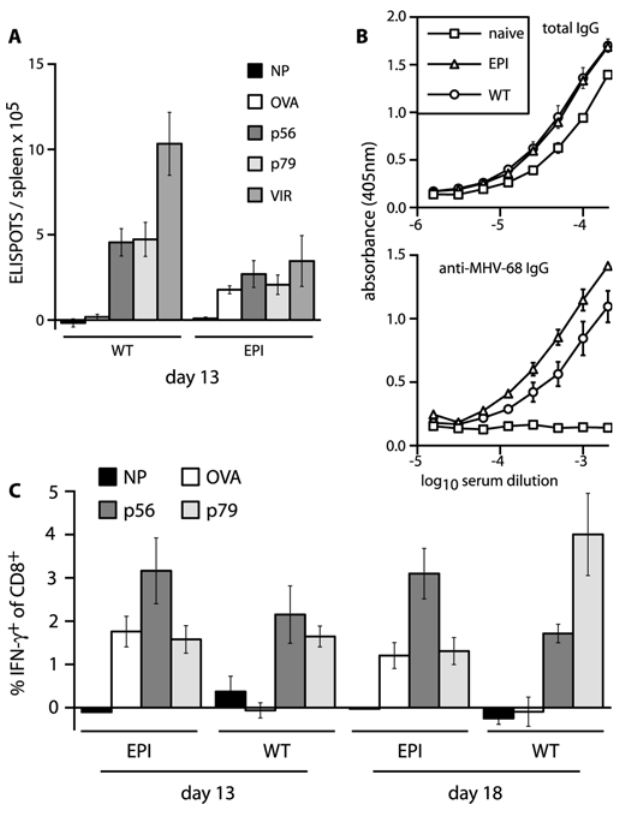
Figure 5. Antigen-Specific Immune Responses to the IRES-EPI Virus (A) CD8 þ and CD4 þ T cell responses were measured by interferon- gamma ELISPOT assay 13 d post-infection. The response to virus- exposed targets (VIR) is mediated by CD4 þ T cells; the response to the p56, p79, and SIINFEKL (OVA) peptides is mediated by CD8 þ T cells [62]. The mean number of spots with untreated targets was subtracted from the number of spots with each specific target. There was a response to the OVA peptide in the IRES-epitope construct, but not to the ASNENMETM peptide (NP). Mean 6 SD values of five mice per group are shown. (B) Total and MHV-68 virion-specific serum IgG responses were measured by ELISA at 18 d post-infection. ‘‘ Naive ’’ indicates age- matched, uninfected controls. Mean 6 SD absorbance values of four mouse sera per group are shown. (C) Spleen cells were stimulated for 5 h in the presence of Brefeldin A plus the peptide indicated and then stained for cell-surface CD8 and intracellular interferon-gamma. The percentage of interferon- gamma þ CD8 þ cells without peptide was subtracted from the value with peptide to give the specific response. Mean 6 SD values of five mice per group are shown. DOI: 10.1371/journal.pbio.0030120.g005